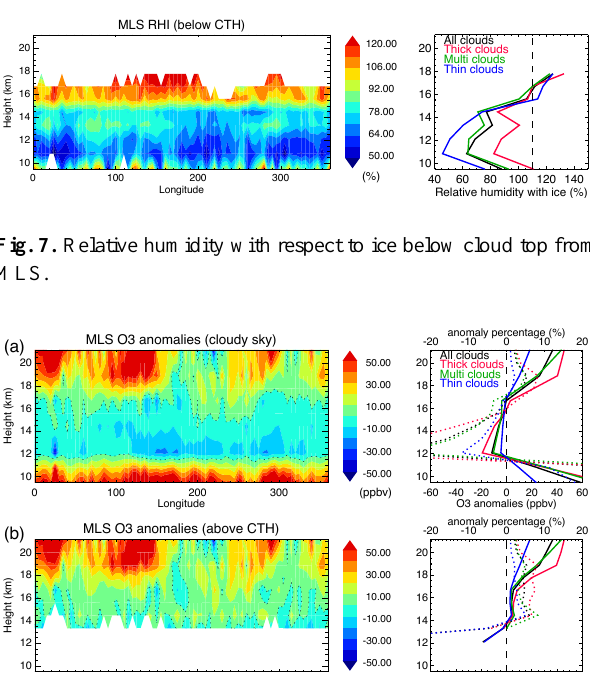
Here, θ is potential temperature, and A is either water vapor ( q ) or ozone (O 3 ). We used a nine-month average for the observed variables. Table 2 shows an example at 15.6 km. The variation of all three variables, having the same sign as each gradient variation, suggests air descent. Additionally, the observed water vapor and ozone anomalies are two or three times larger than expectations based on temperature. This means that the temperature change is reduced by mixing and cooling during